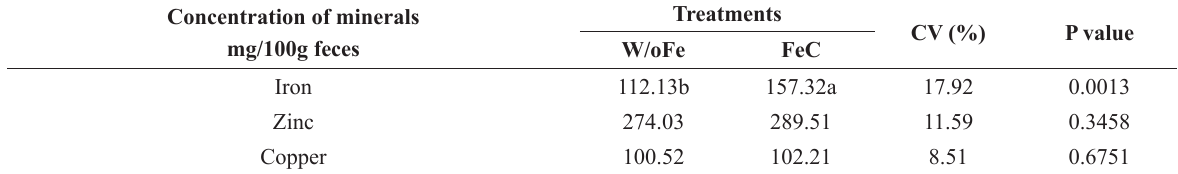
Concentration of iron, zinc and copper (mg/100g) in the feces of pregnant sows fed diets with or without iron chelate supplementation.